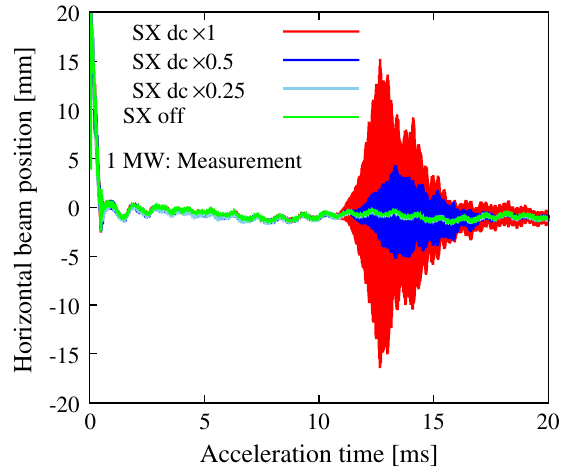
FIG. 25. Measured beam instability mitigation at a beam power of 1 MW by reducing the degree of chromaticity correction using the same patterns as those applied in the simulations (Fig. 24). Similar to the simulation results, the designed 1 MW beam acceleration was accomplished by keeping ξ as close as possible to the natural value with SX dc × 0 . 25 or SX